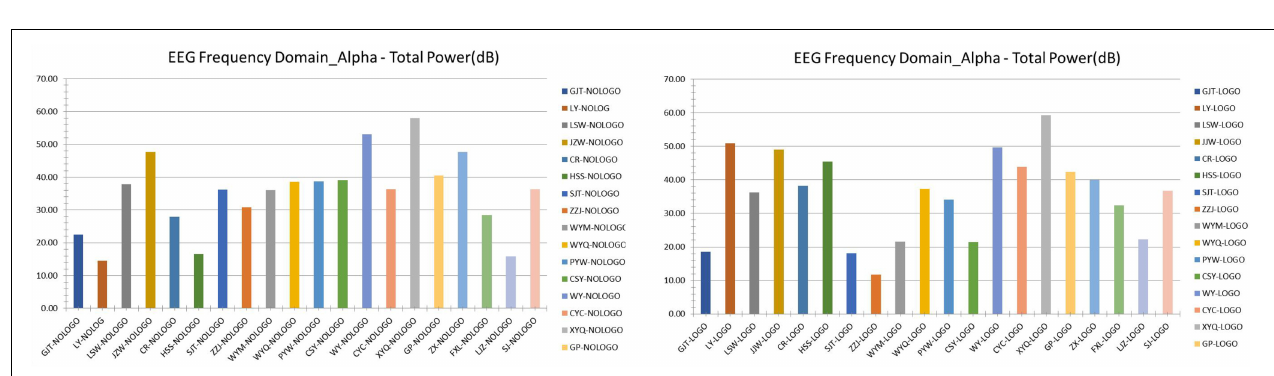
FIGURE 7 | EEG indicator records of individual samples displayed on the ErgoLAB platform during the experiment (Search and take screenshots from ErgoLAB by our research team).